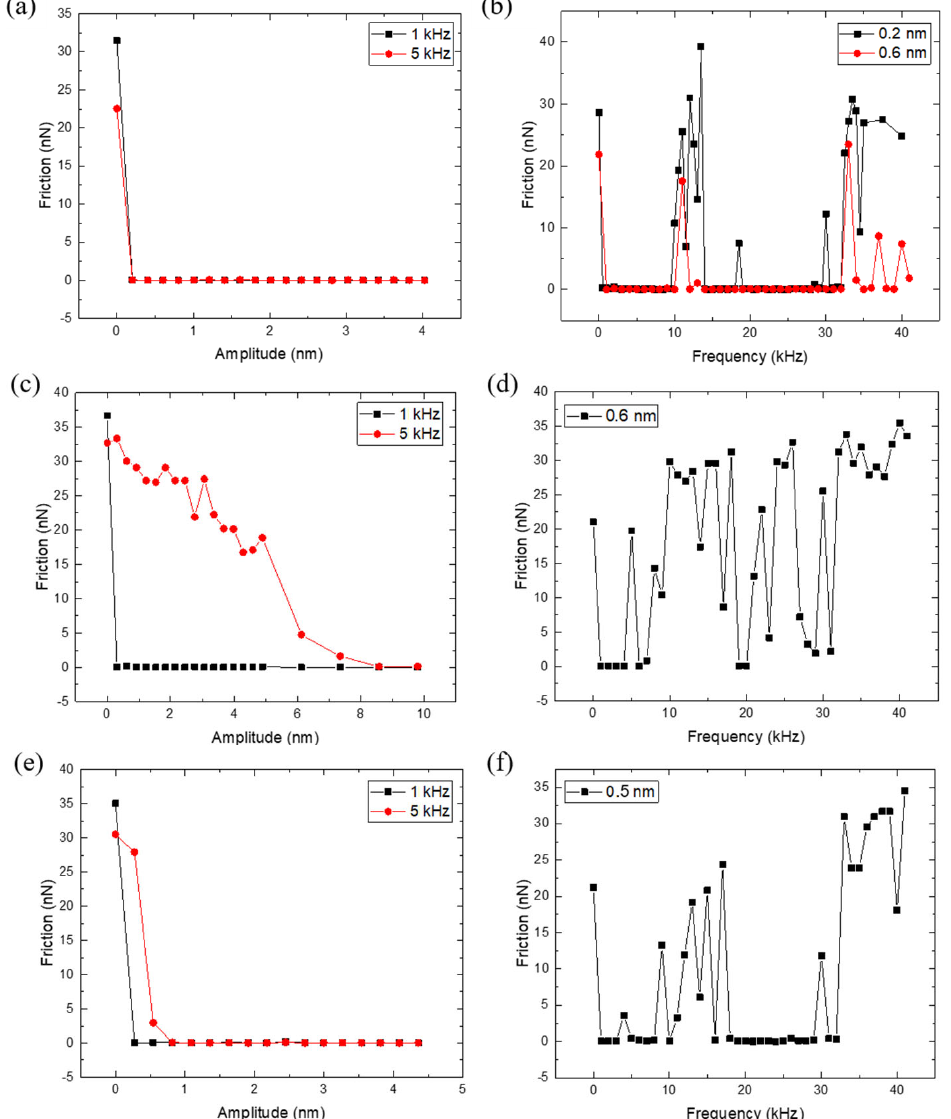
Fig. 8 Friction detected by scanning on the atomic-scale HOPG surface as a function of the (a) z -directional vibration amplitude at 1 and 5 kHz frequencies, (b) z -directional vibration frequency at 0.2 and 0.6 nm amplitudes, (c) x -directional vibration amplitude at 1 and 5 kHz frequencies, (d) x -directional vibration frequency at 0.6 nm amplitude, (e) y -directional vibration amplitude at 1 and 5 kHz frequencies, and (f) y -directional vibration frequency at 0.5 nm